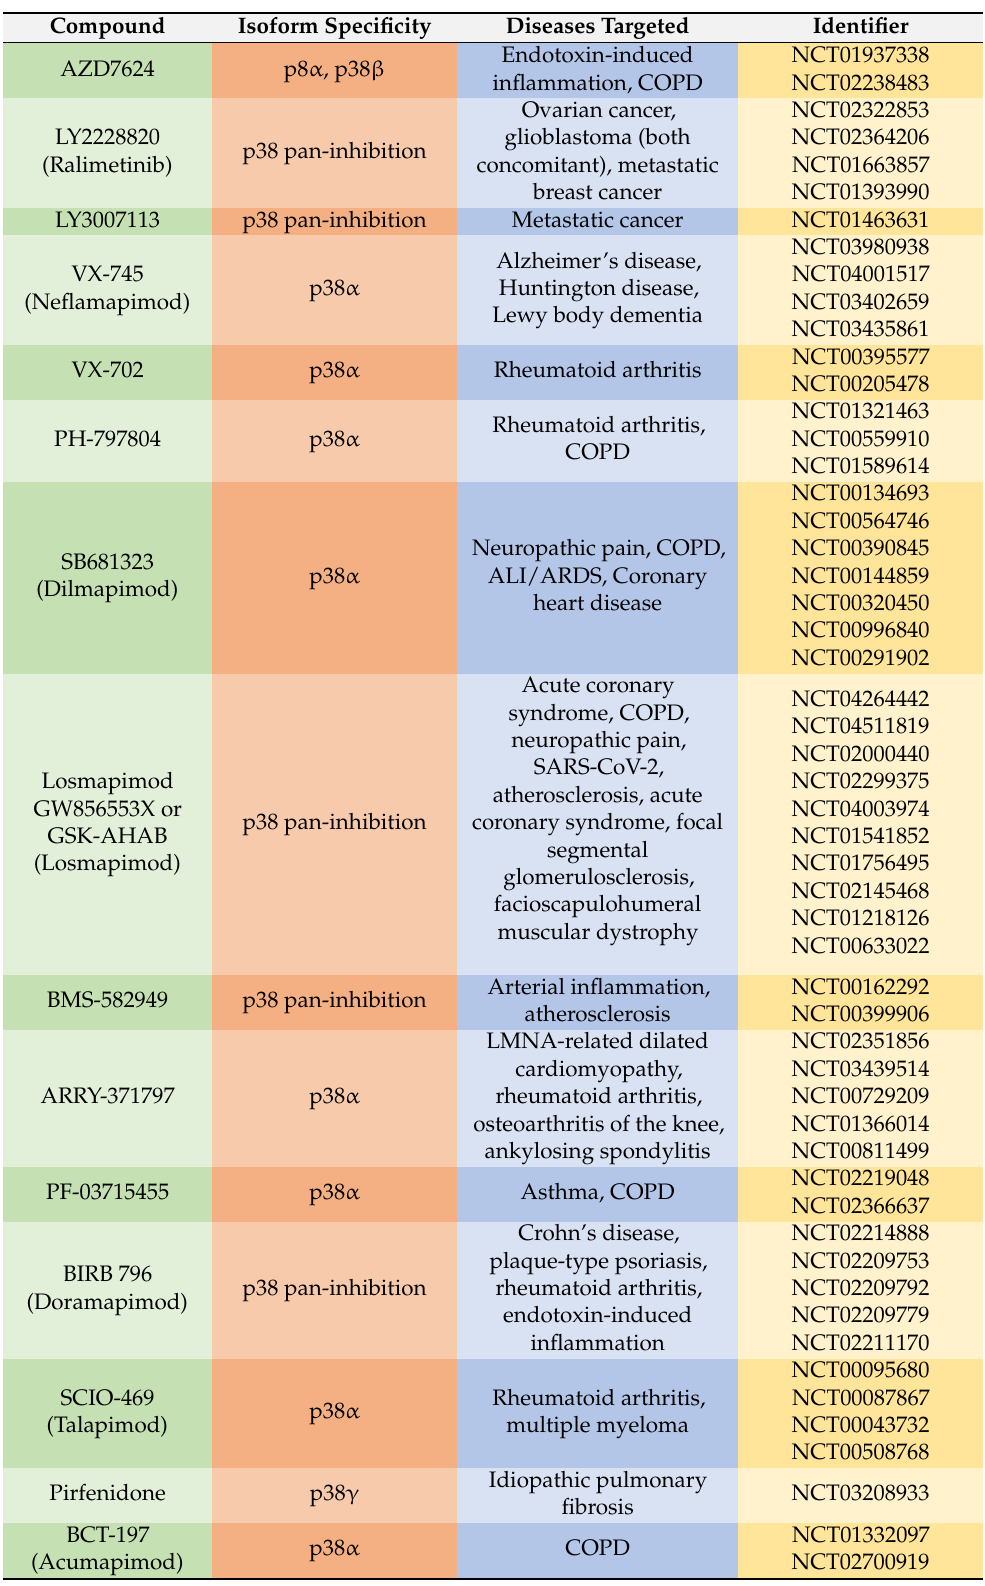
Table 1. Clinical trials targeting p38 mitogen-activated protein kinase